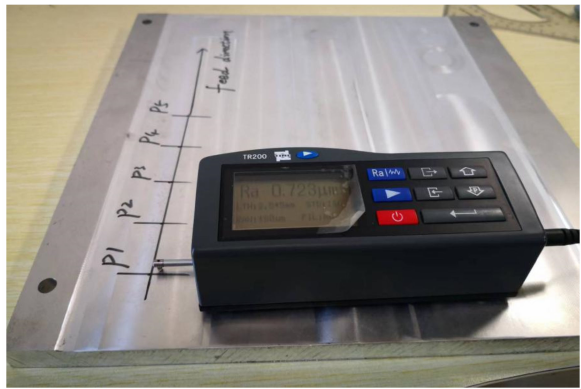
Figure A1. The measurement experiment for lapping quality.